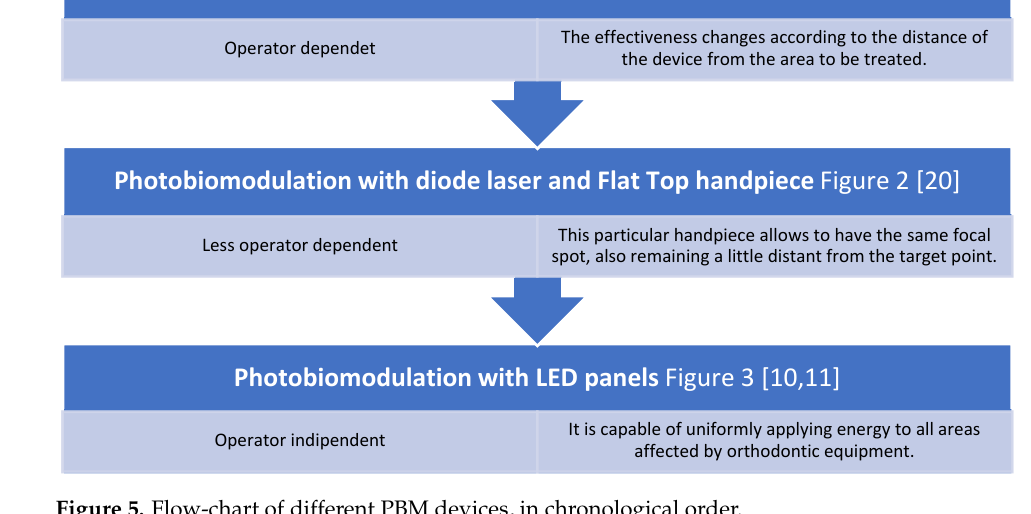
Figure 5. Flow-chart of different PBM devices, in chronological order.